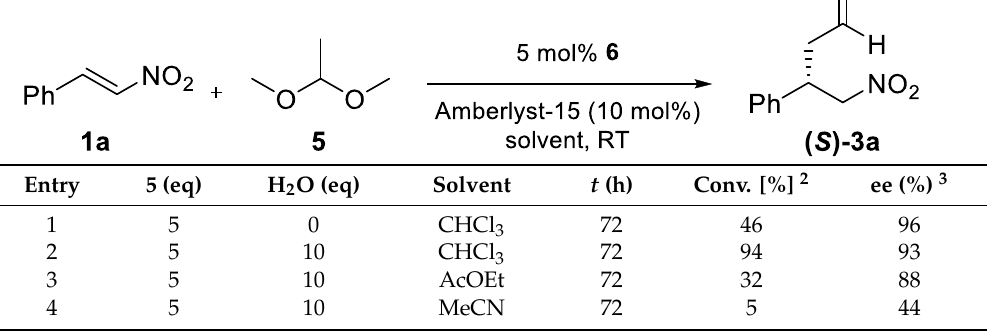
Table 2. Optimization of conditions for the Michael addition 1.